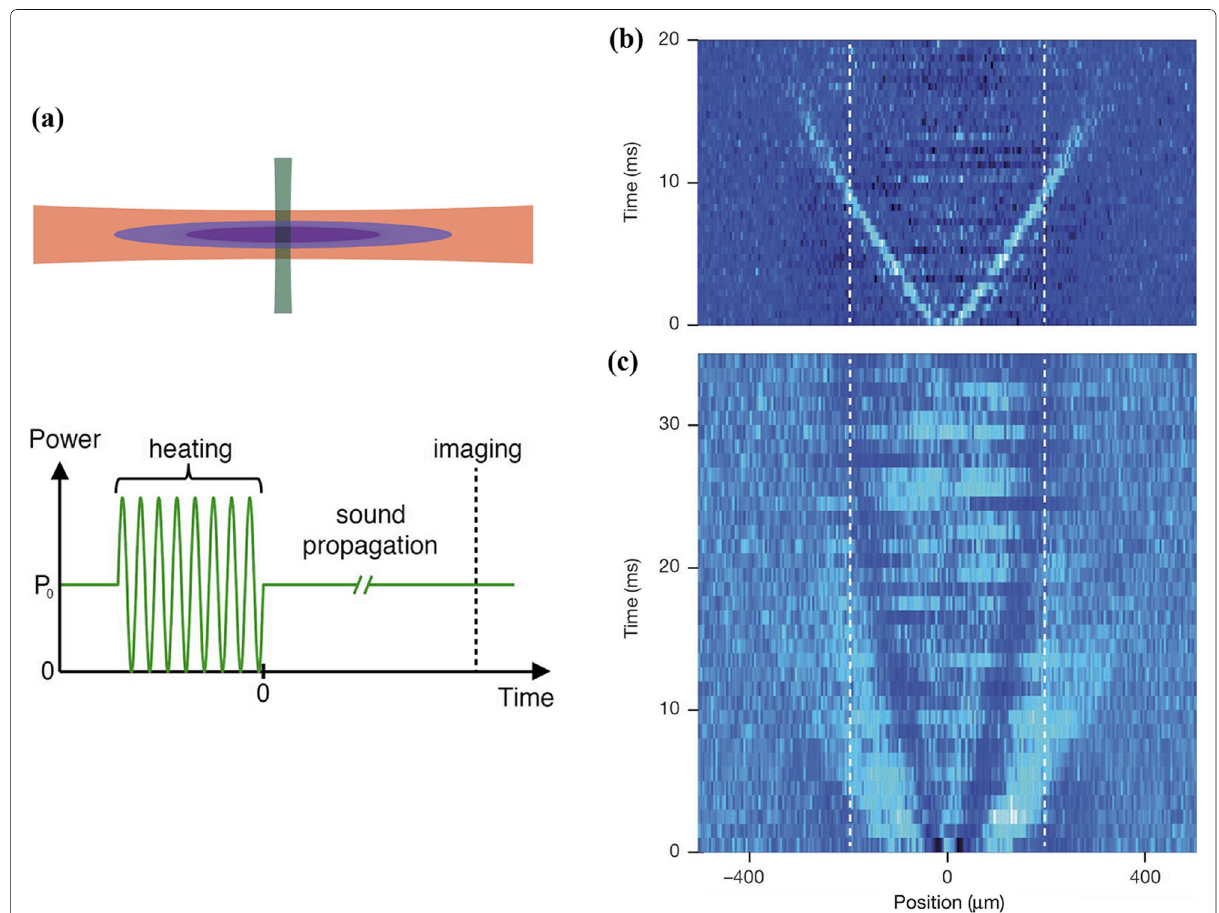
Fig. 9 a A second sound wave is excited by a weak, power-modulated repulsive laser beam (green) that perpendicularly intersects the cigar-like Fermi cloud (purple) with a total N = 3 × 10 5 6 Li atoms. The short power-modulation burst contains eight sinusoidal oscillations (i.e., heating) in 4.5 ms. The sinusoidal oscillations are absent if a first sound wave is excited. b , c Normalized differential axial density profiles, measured for variable delay times after the excitation, show the propagation of first sound (local density increase, bright) and second sound (local decrease, dark). The temperature of the Fermi cloud is T = 0.135 ( 10 ) T F , where T F = (cid:2) ( 3 N ω 2 ⊥ ω z ) 1 / 3 is the Fermi temperature in traps. The vertical dashed lines